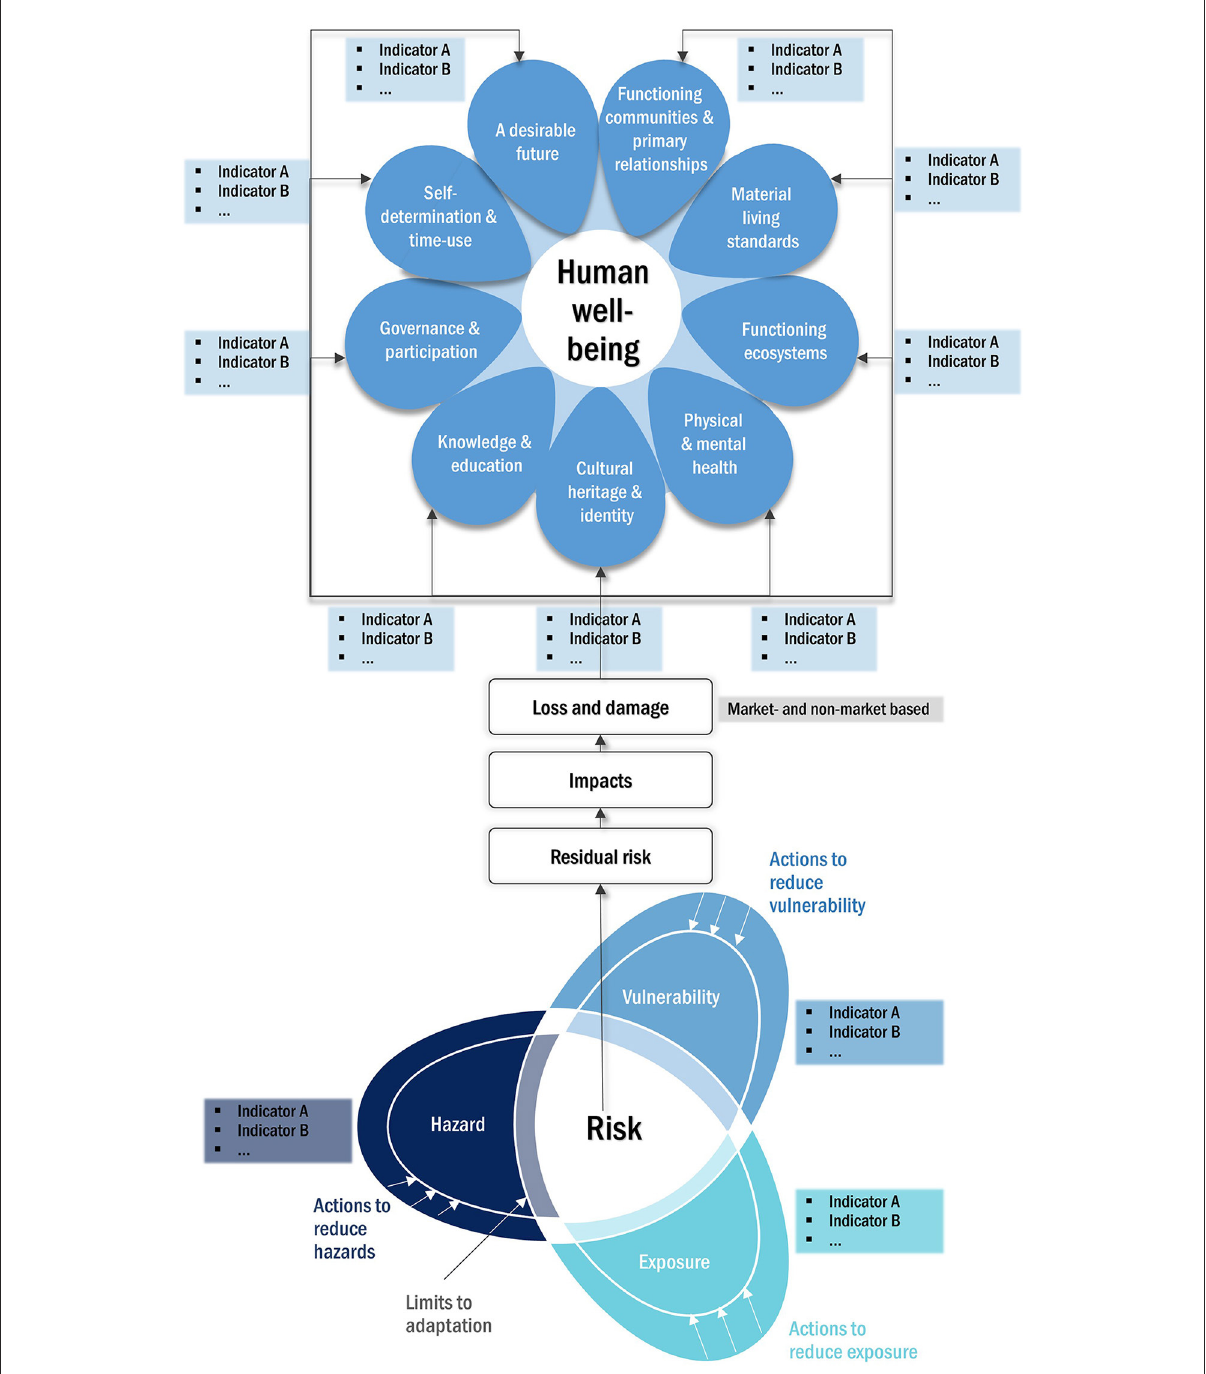
FIGURE1 Human well-being as an approach to identify market-based and non-market-based loss and damage from climate-related risks. Climate-related risks manifest through a combination of three domains: hazard, exposure, and vulnerability. In all three dimensions, risk reduction measures may be taken, but simultaneously there may be limits to adaptation.